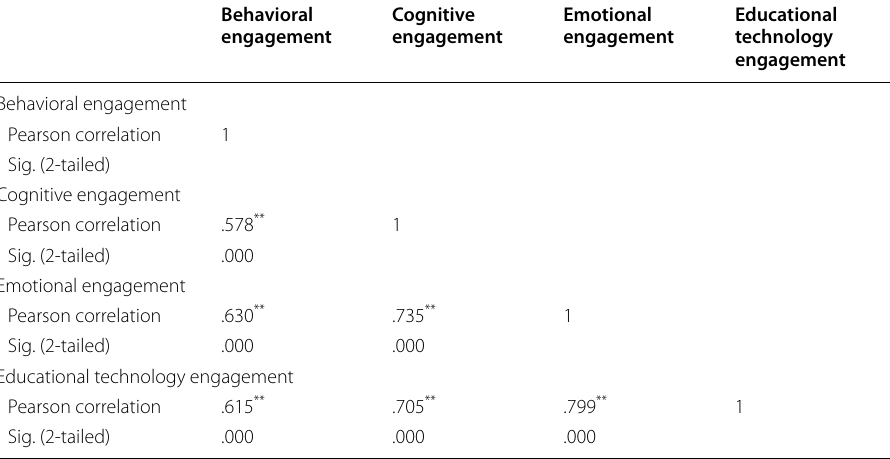
Table 4 Correlations between behavioral engagement, cognitive engagement, emotional engagement and educational technology engagement